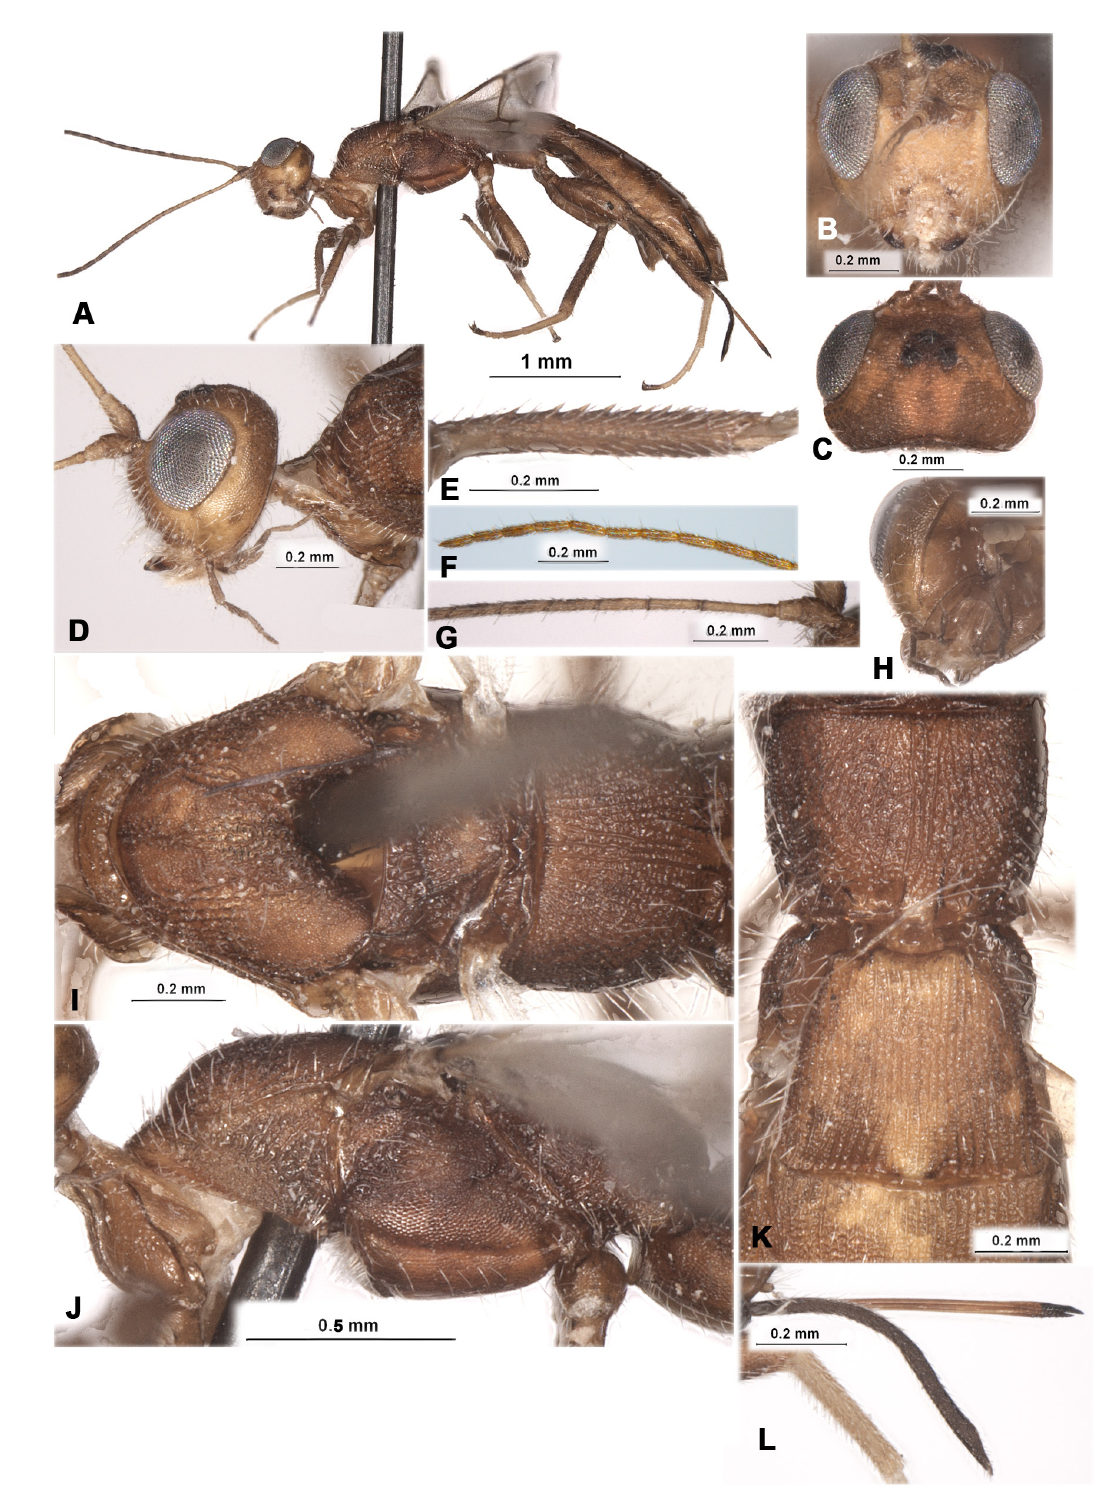
Fig. 12. Mimodoryctes proprius Belokobylskij, 2001, holotype, ♀ (MNBG). A . Habitus, lateral view. B . Head, front view. C . Head, dorsal view. D . Head, lateral view. E . Fore tibia. F . Apical segments of antenna. G . Basal segments of antenna. H . Head, latero-posterior view. I . Mesosoma, dorsal view. J . Mesosoma, lateral view. K . Propodeum and first tergite of metasoma, dorsal view. L .